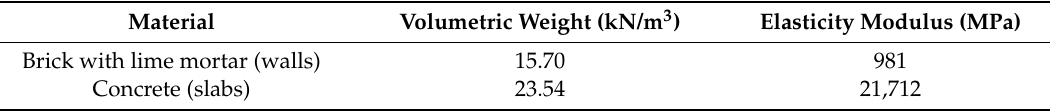
Table 1. Mechanic properties used for the numerical model.